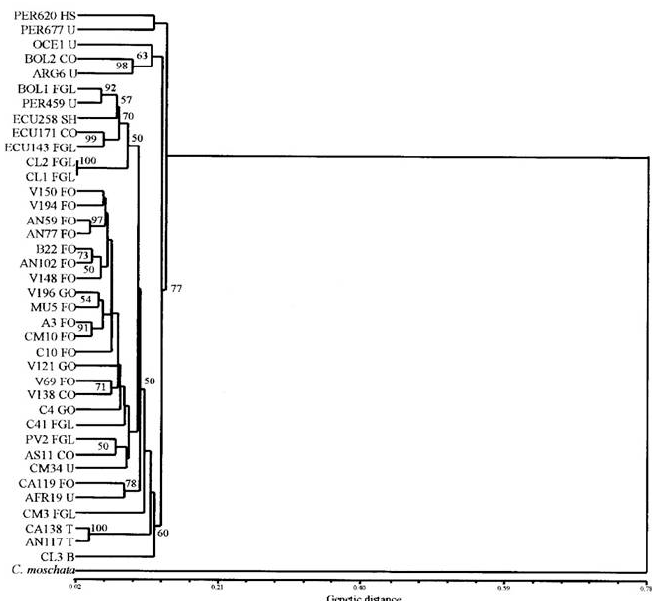
Figure 13. Relationships among 38 accessions of C. maxima using AFLP markers based on Dice distance. Bootstrap values are indicated. Entry codes beginning with PER, ARG, BOL, ECU, OCE and AFR are from Peru, Argentina, Bolivia, Ecuador, New Zealand and Morocco, respectively. The rest of the entries are from Spain. Adapted from [69].